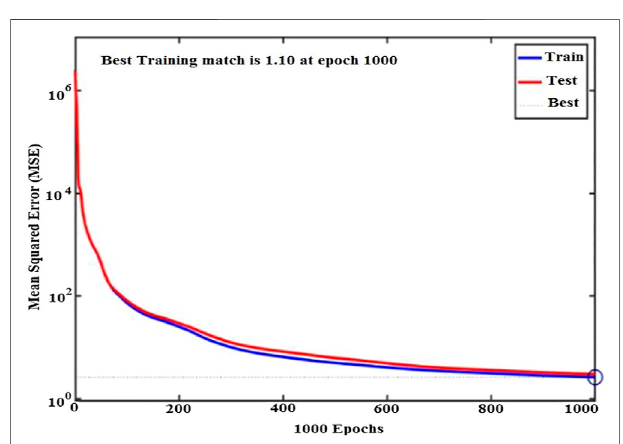
FIGURE 7 | Mean square error with number of